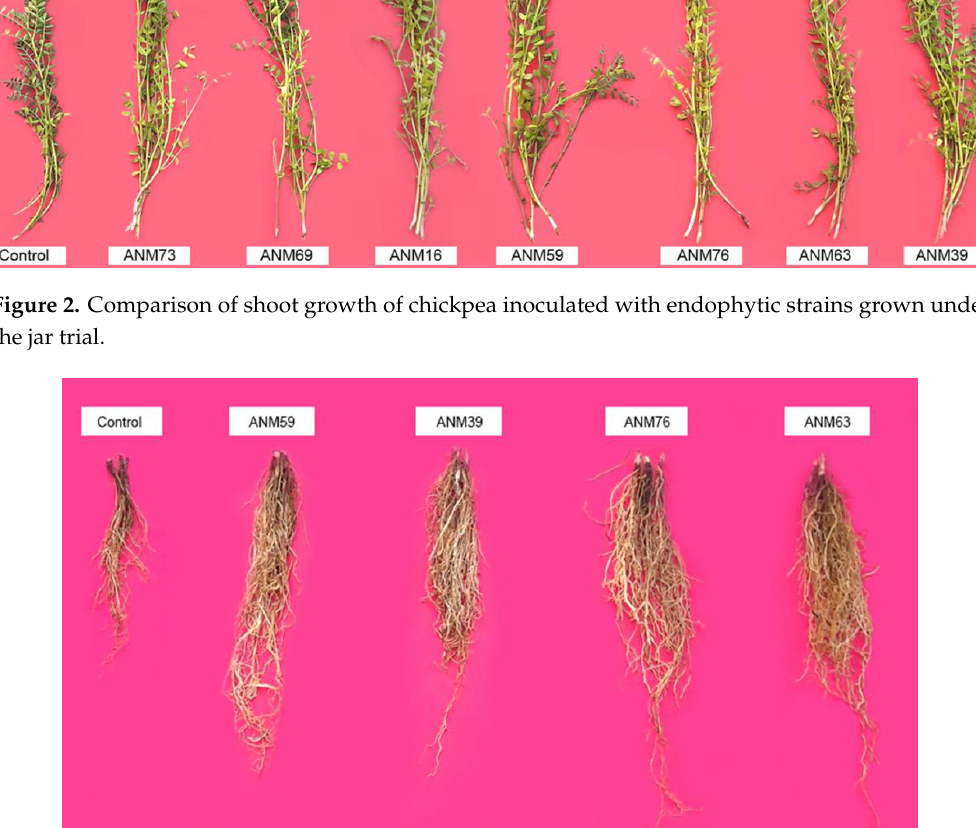
Figure 3. Comparison of growth of selected chickpea roots inoculated with endophytic strains grown under the jar trial.